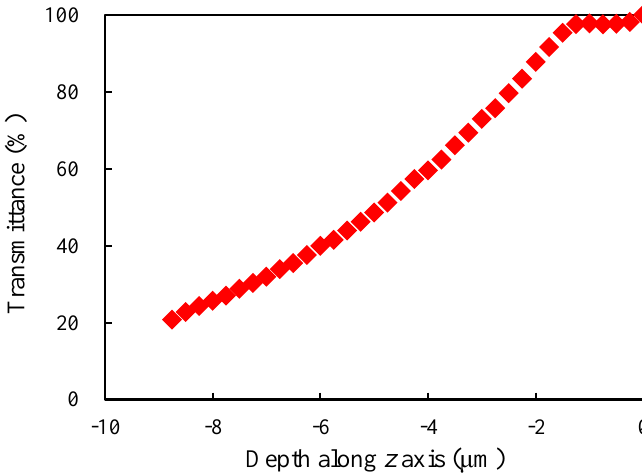
Figure 9. Evolution of the transmittance with the depth along z axis for the 7 × 7 × 9 µ m 3 models.